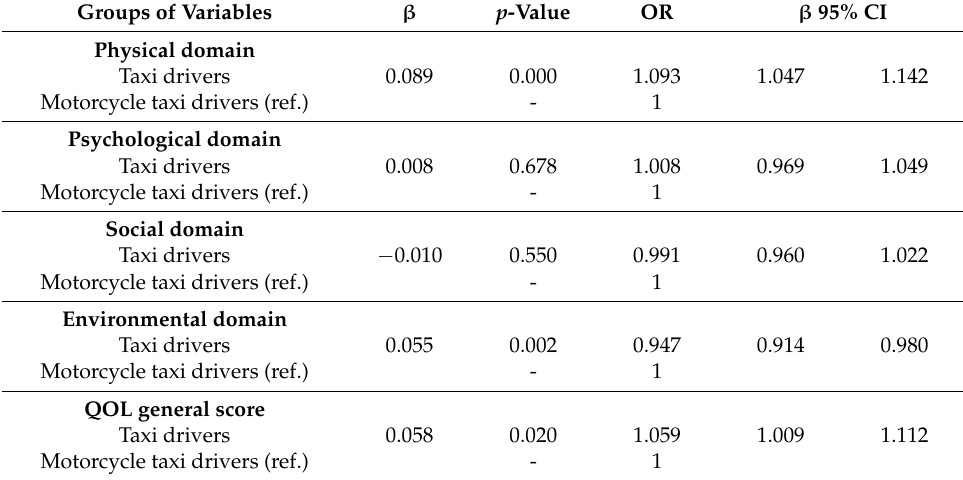
Table 4. Binary logistic regression analysis for the QOL domains and overall QOL score according to occupation.